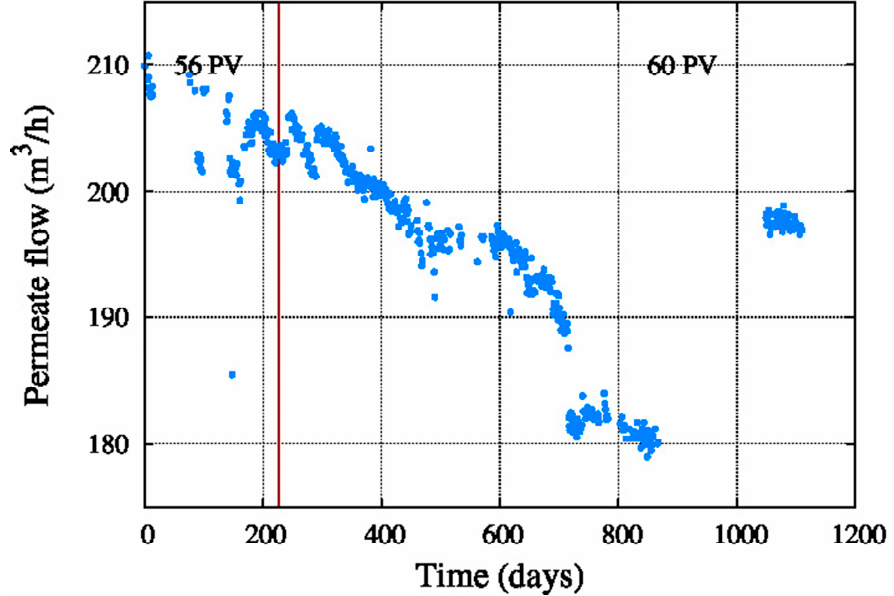
Figure 7. Permeate flow.